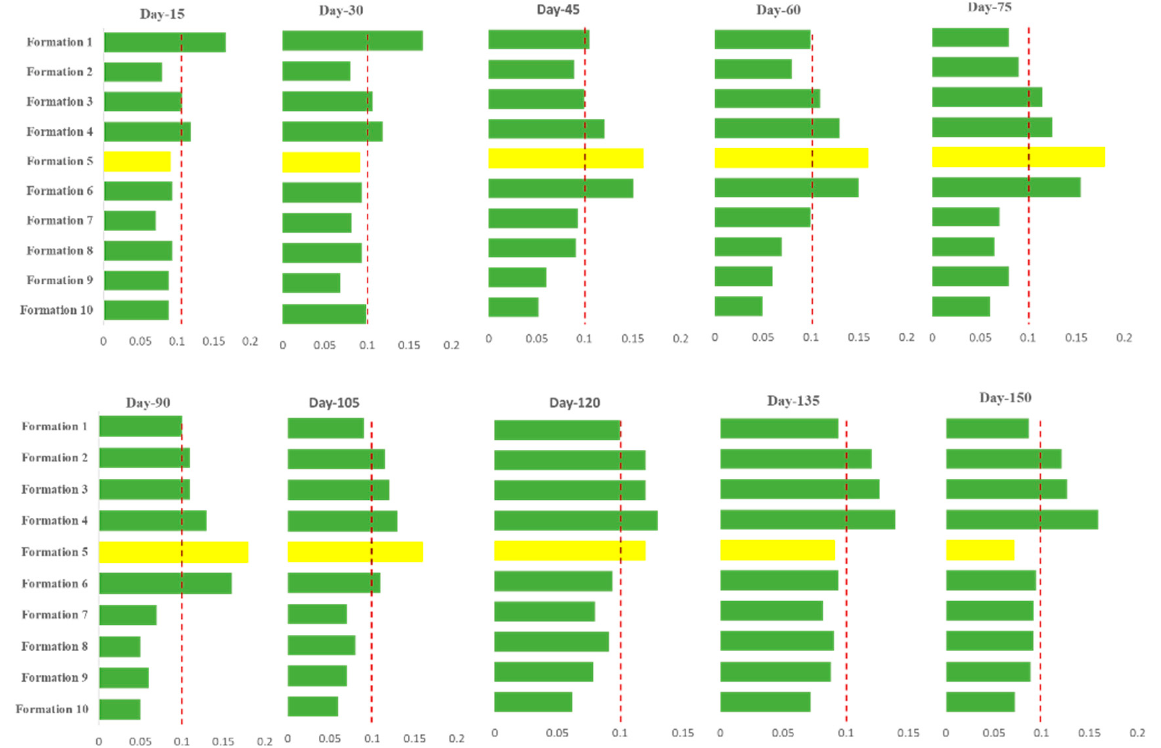
Figure 16. Five months production profiling. The fracturing operation started on day 15, and the contribution rate of the target formation increased significantly from day 15, which matches the actual production data. The dashed line in the graph shows the average contribution rate of all formations. It is obvious from the graph that the contribution rate of Formation 2, 3, 4, 5 and 6 exceeds the average, which leads to the conclusion that the fracture height extends up to Formation 2 and down to Formation 6.